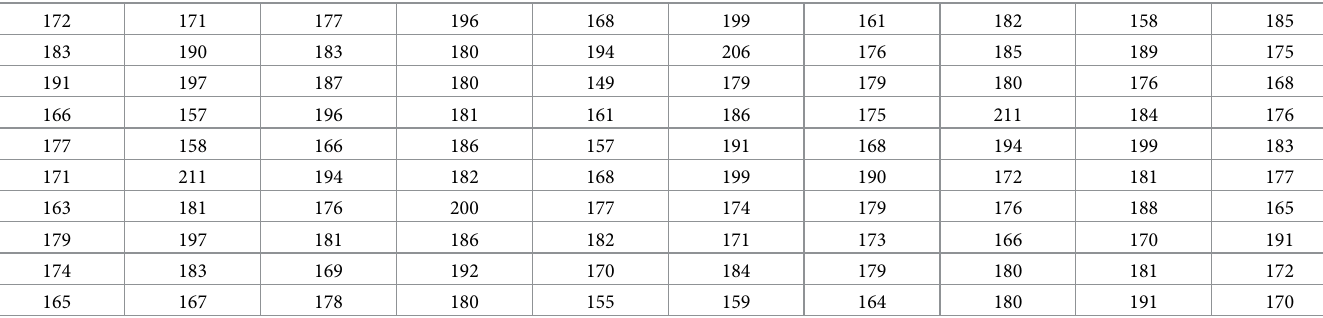
Table 2. The 100 measured counts each obtained within 10 second-intervals using a GM